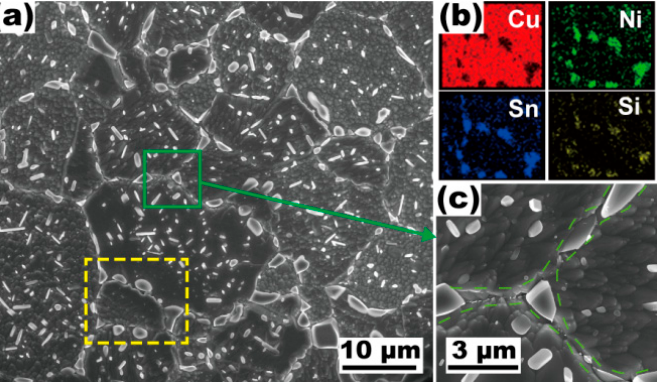
Figure 6. SEM micrographs of the Cu-15Ni-8Sn-0.3Si-0.1Ti alloy after annealing at 1093 K for 1 h. ( a ) Grain morphology in the alloy; ( b ) the EDS-mapping result corresponding to the yellow rectangle in ( a ); ( c ) higher magnification image of the green domain in ( a ), intergranular micron particles are highlighted by the green dotted line.